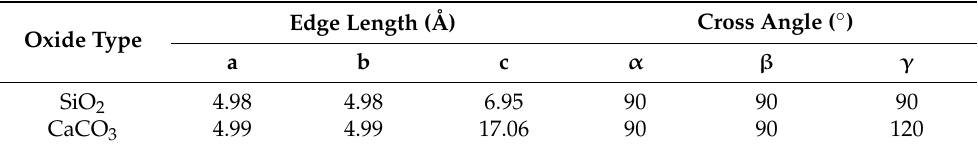
Figure 6. ( a ) The single-cell model of SiO 2 ; ( b ) The single-cell model of CaCO 3 . Table 2. Single-cell model parameters of SiO 2 and CaCO 3 .